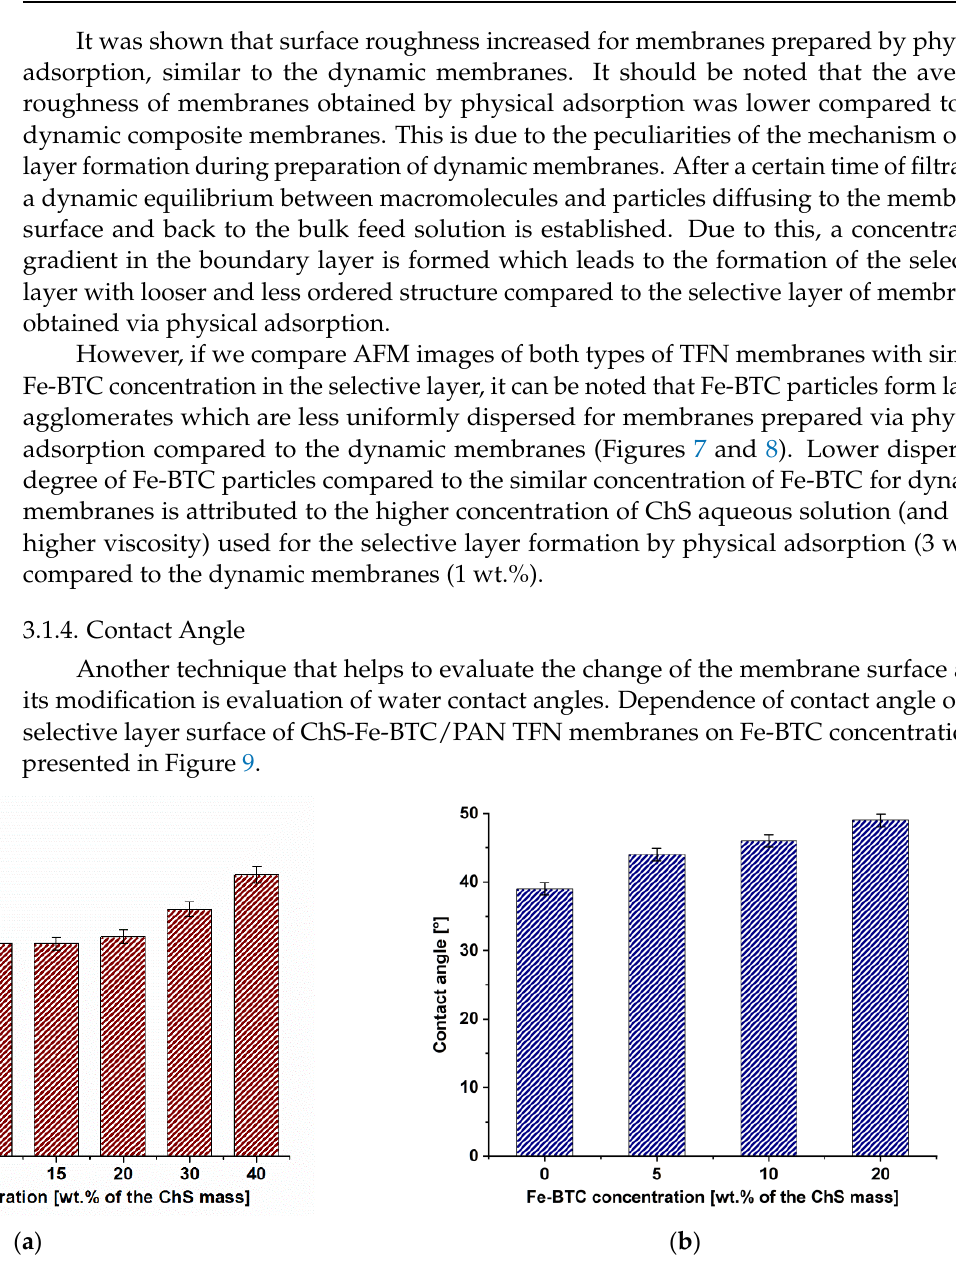
Figure 9. Dependence of water contact angle of the selective layer surface of ChS-Fe-BTC/PAN TFN membranes on Fe-BTC concentration: ( a )—dynamic membranes, ( b )—membranes prepared by physical adsorption.